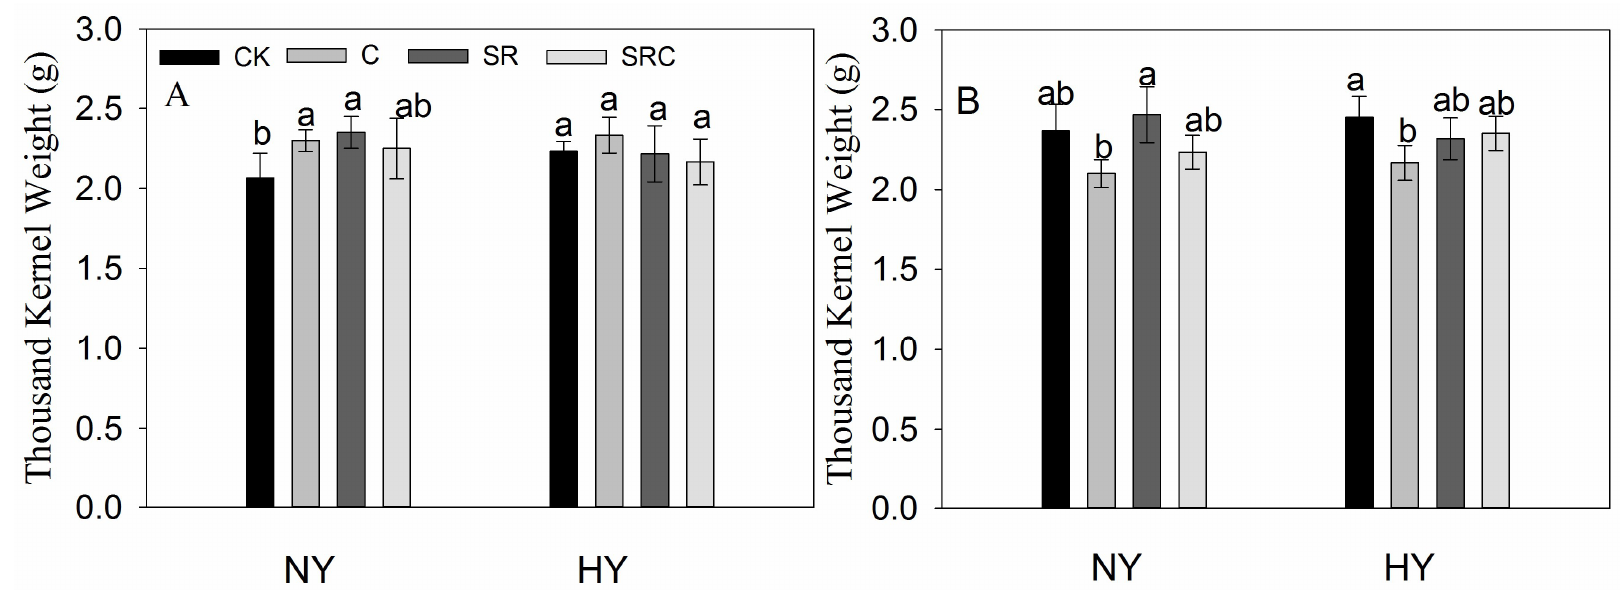
Figure 2. Effects of biochar and soft rock treatments on the thousand kernel weight of millet grown in two fertilizer levels conducted in 2018 ( A ) and 2019 ( B ). CK, sand only; C, sand and biochar; SR, sand and soft rock; SRC, sand, biochar, and soft rock; NY, normal yield pattern; HY, high yield pattern. Data were shown in mean ± SE. Different letters indicate significant differences ( p < 0.05).